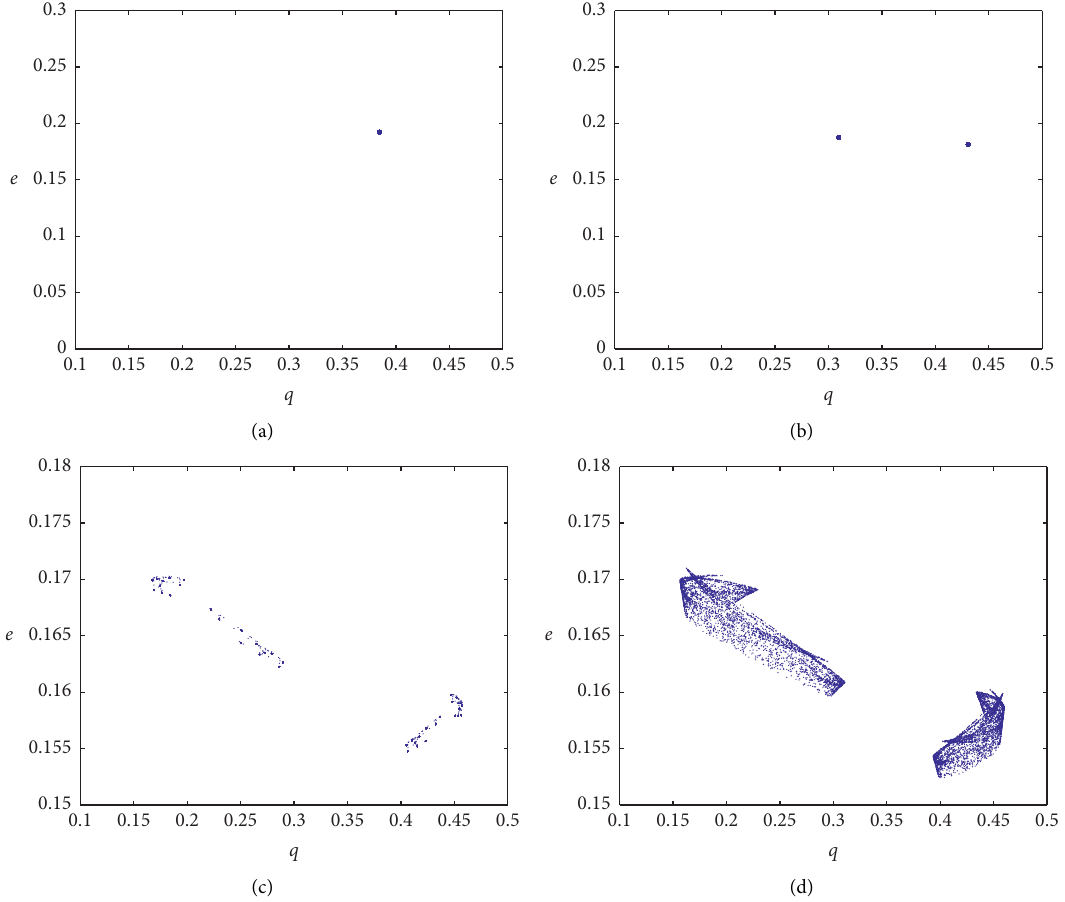
Figure 9: The chaotic attractor of dynamic system (25) changes with α (c) α q � 3 . 8 , α e � 0 . 5. (d) α q � 3 . 9 , α e � 0 .